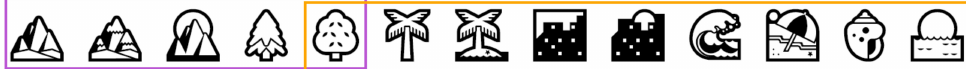
Figure 3. Emojis attributed as location-specific, selected from global sunrise- (purple) and sunset- typical (orange)